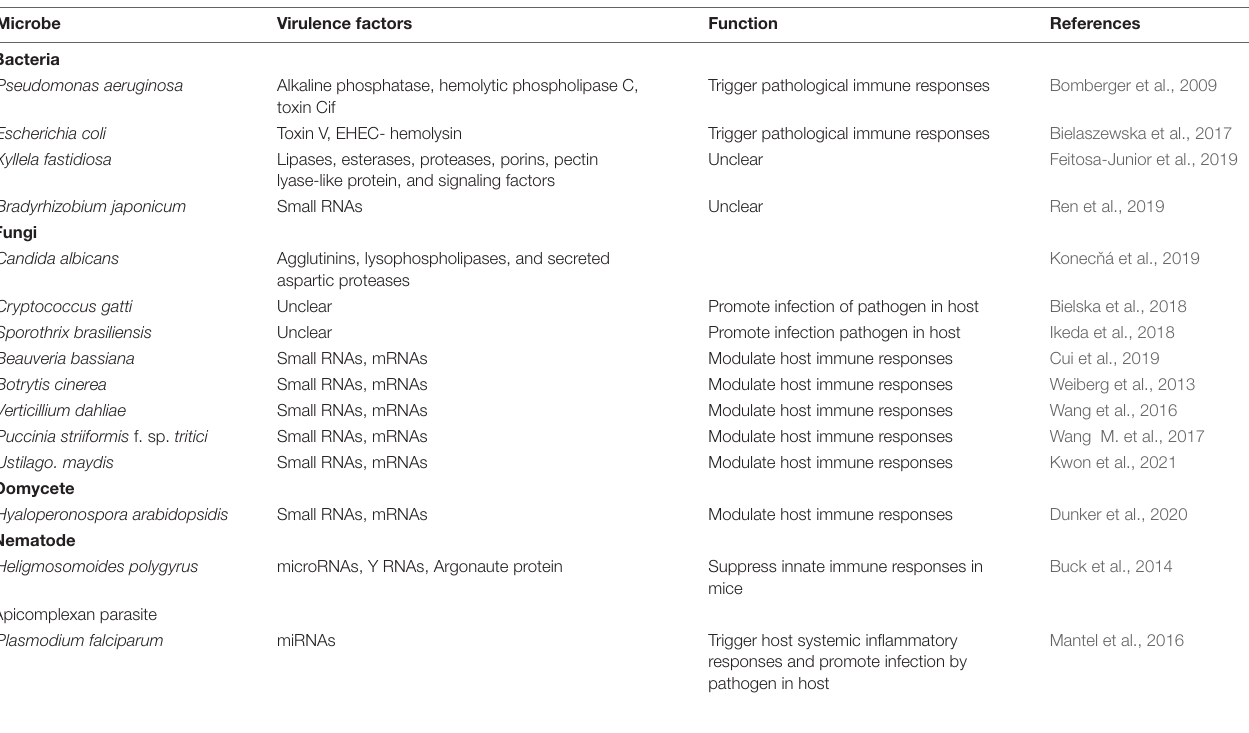
TABLE 2 | Virulence factors delivered by EVs and function during pathogen infection. Microbe Virulence factors